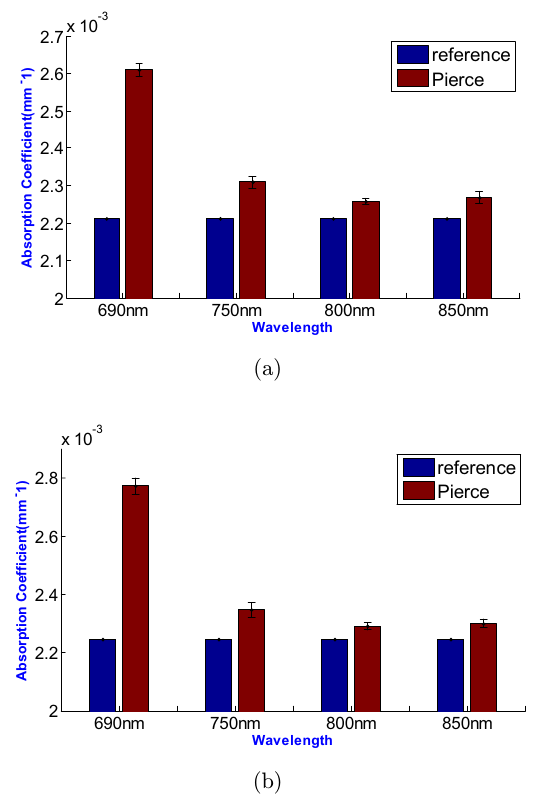
Fig. 8. Reconstructed absorption coe±cient for reference phantom and phantom with Pierce TM PAR inhomogeneity (a) at detector #1 location and (b) at detector #2